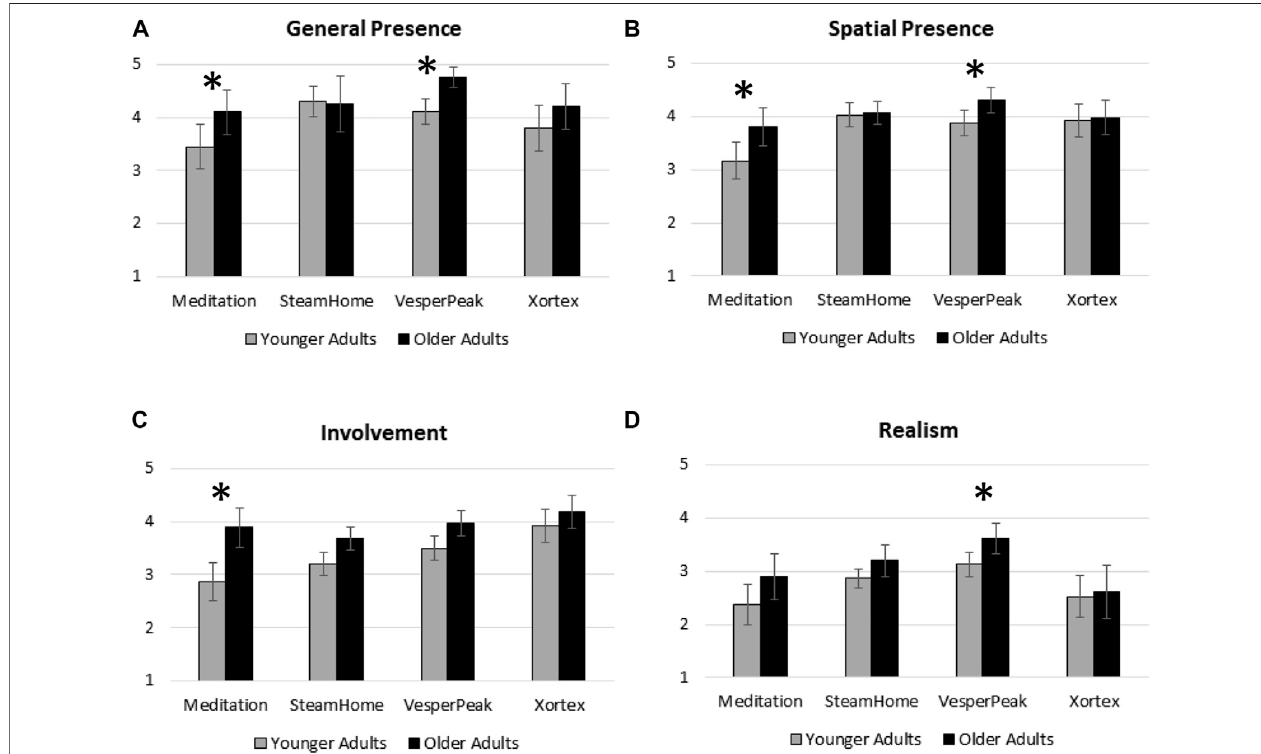
FIGURE1| MeasuresofPresence,Involvement,andRealismasafunctionofageandVRExperience.Errorbarsrepresent95%Con fi denceIntervals.* (cid:1) signi fi cant age contrasts, p < .05. N (cid:1) 20 younger adults, 20 older adults.